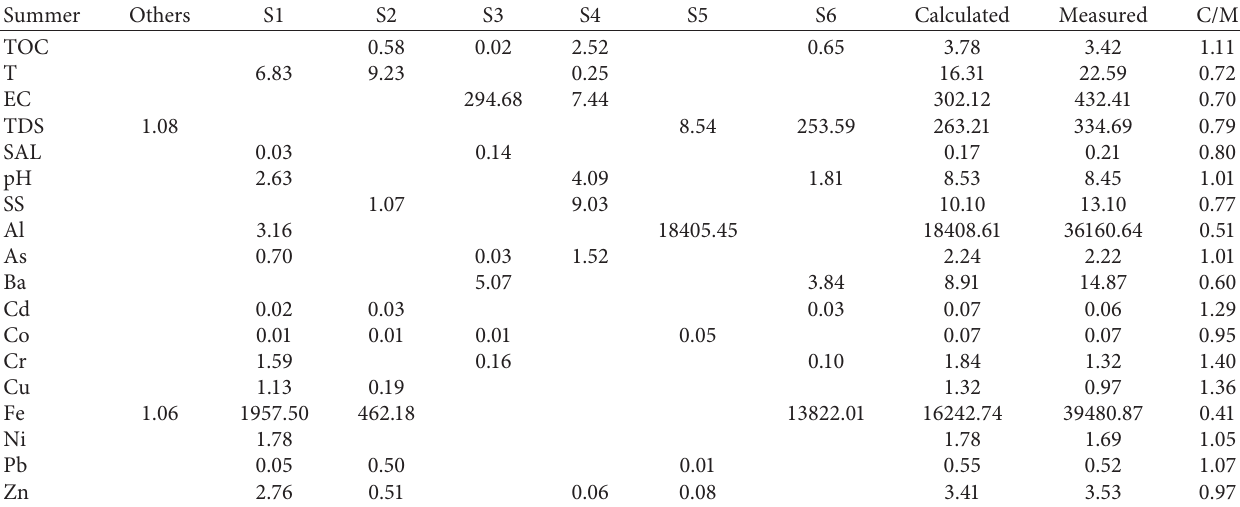
Table 5: Source apportionment for physicochemical parameters and heavy metals in summer. Summer